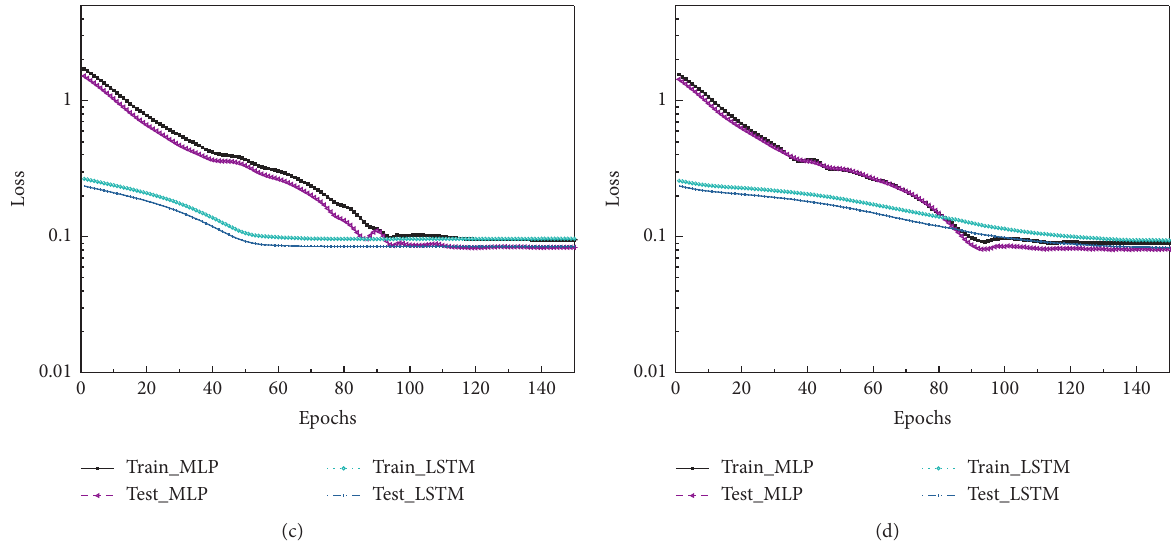
Figure 9: The training and test loss predicted by MLP and LSTM. (a) a